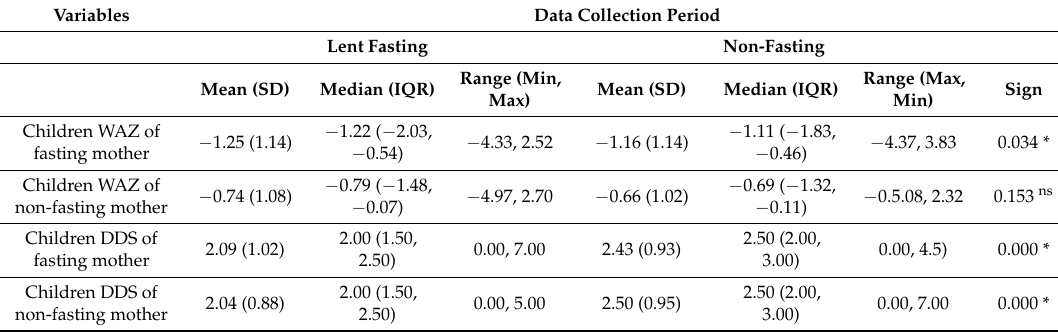
Table 6. Comparison of 6–23-month-old children’s WAZ and DDS values between lent fasting and non-fasting periods in rural Tigray,